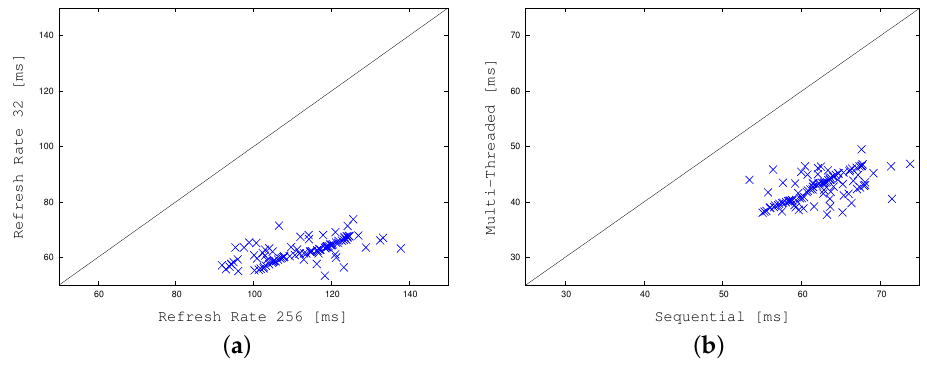
Figure 19. Comparing computation times on the embedded system: ( a ) The sequential implementation with two different refresh rates, and ( b ) The multi-threaded version versus the sequential one.